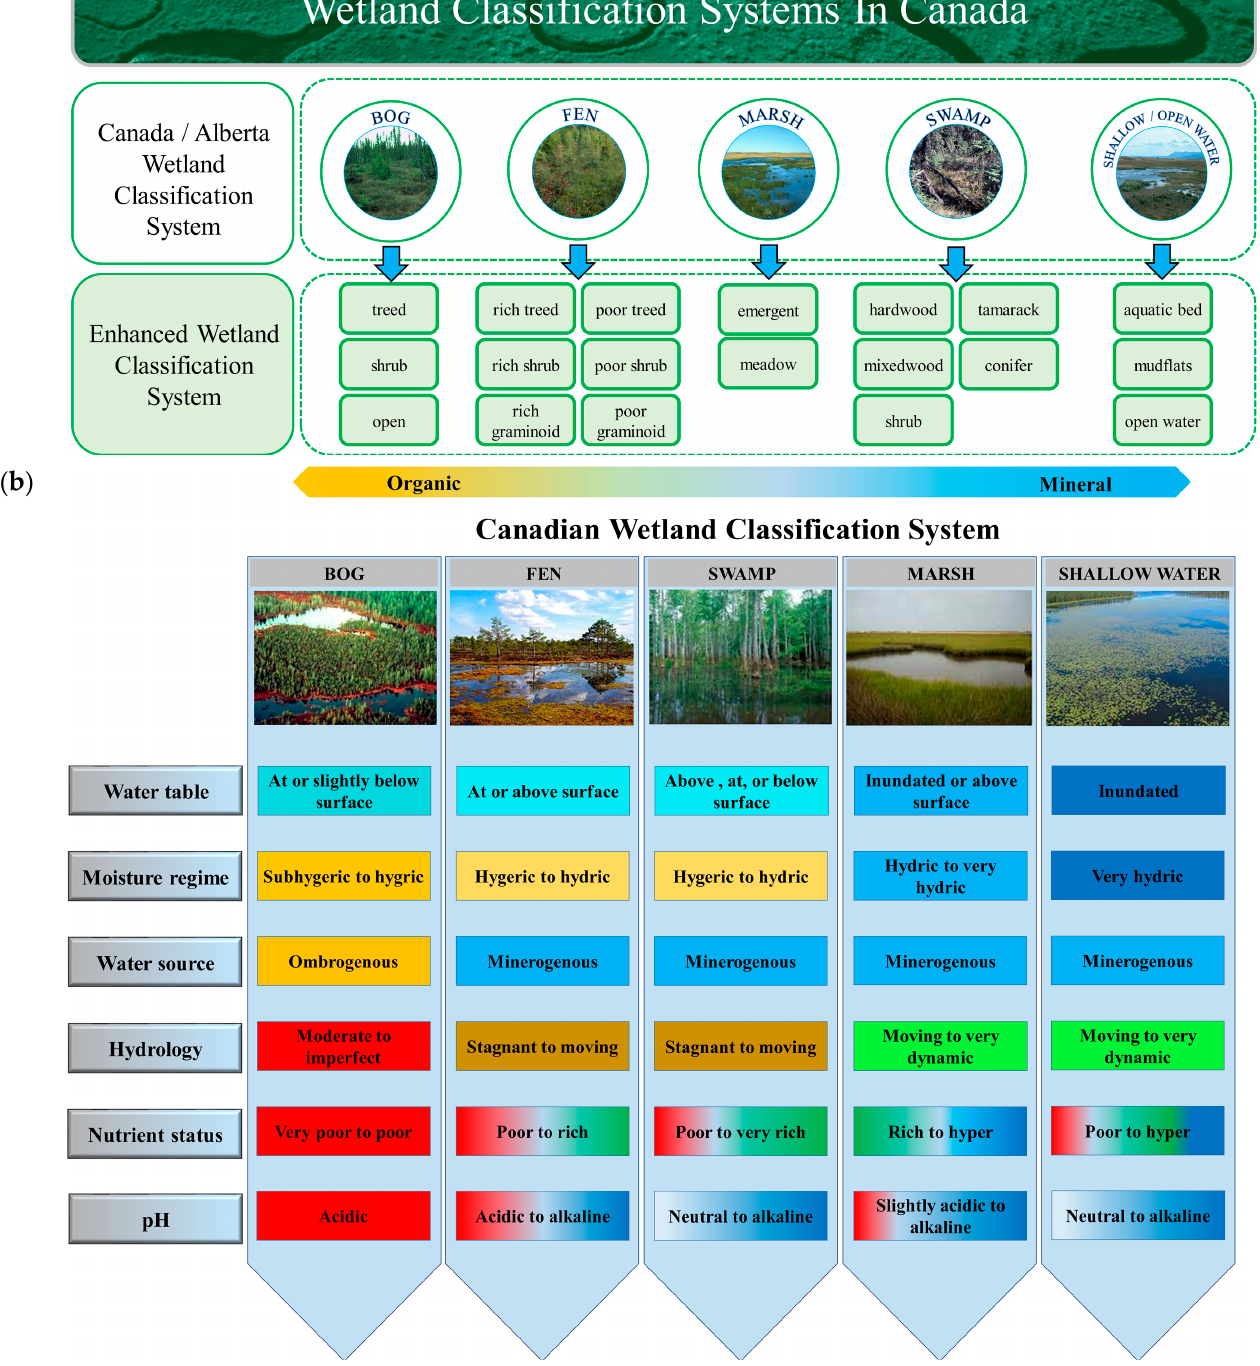
Figure 1. ( a ): The well-known Wetland Classification Systems used in Canada. ( b ): Wetland classes based on the CWCS. Swamps exist in both mineral and peatland wetland types [80]. Swamps are often found in contact with other hydrological systems; hence they are difficult to identify. One of the distinguishing characteristics of swamps is that the woody vegetation (trees